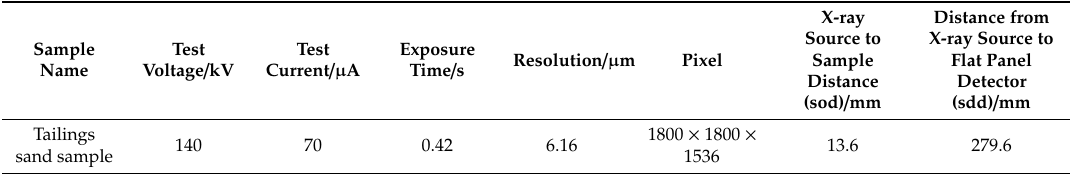
Figure 3. nanoVoxel-3000 micro-CT.